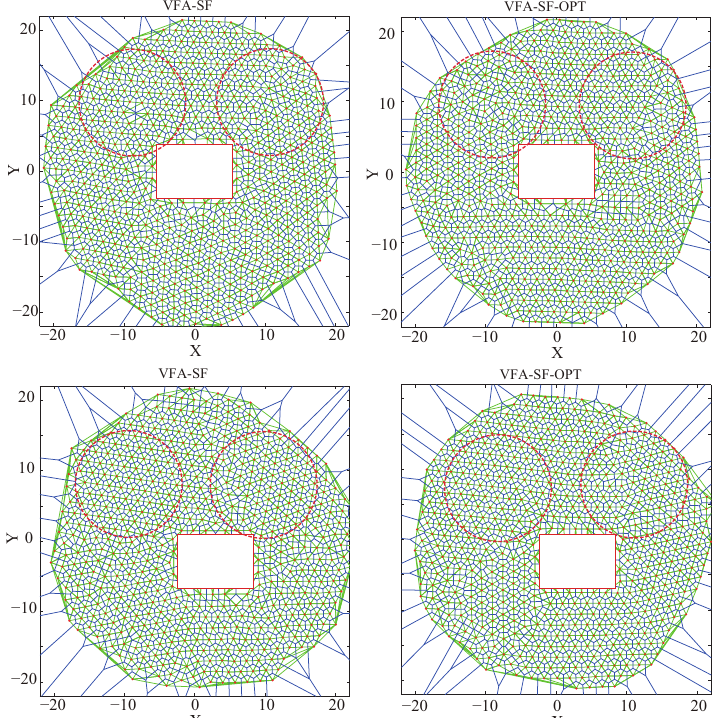
Figure 9. Final node deployments from ( left ) the VFA-SF and ( right ) the VFA-SF-OPT for the rectangular obstacle cases: ( top ) when rectangular obstacle is at the center; ( bottom ) when the rectangular obstacle is off-center. Red dashed circles, region used to calculate the PCD